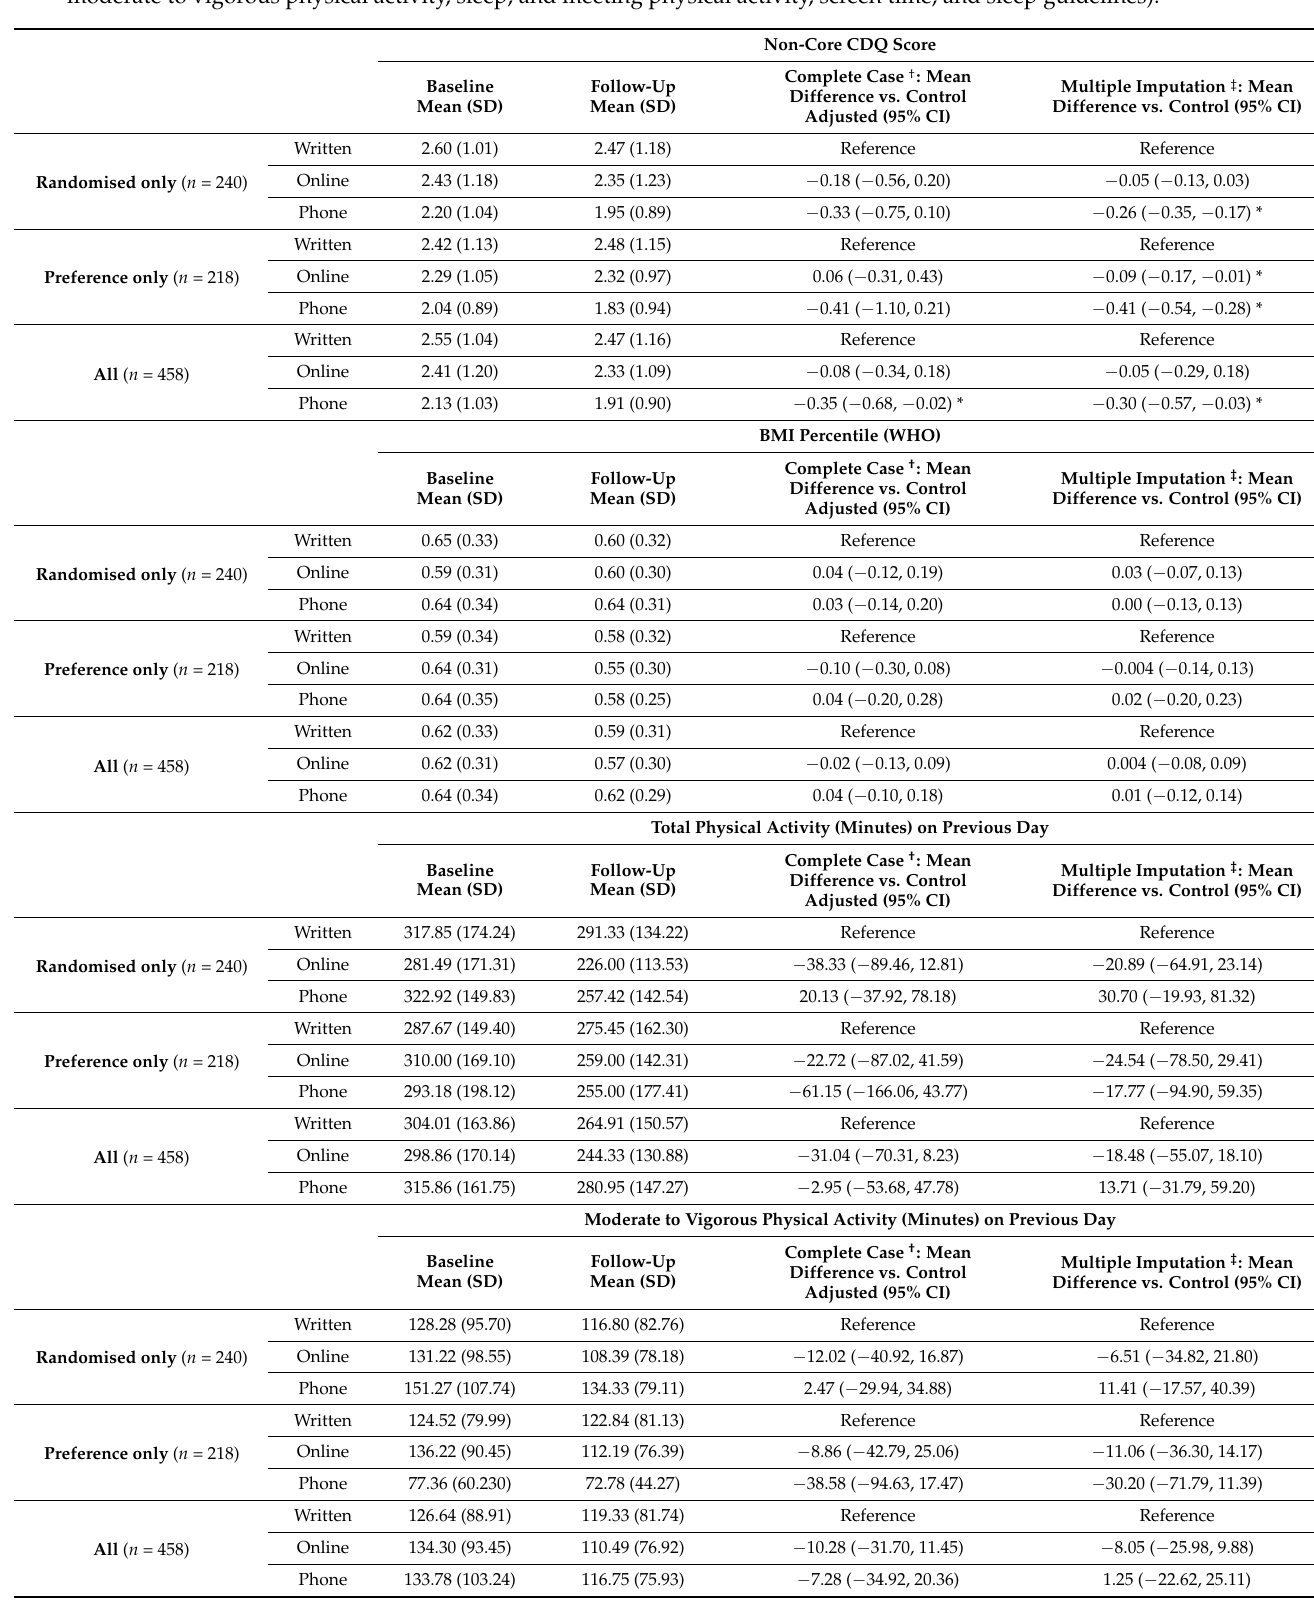
Table 3. Results for secondary outcomes by study group (non-core food intake, BMI percentile, total physical activity, moderate to vigorous physical activity, sleep, and meeting physical activity, screen time, and sleep